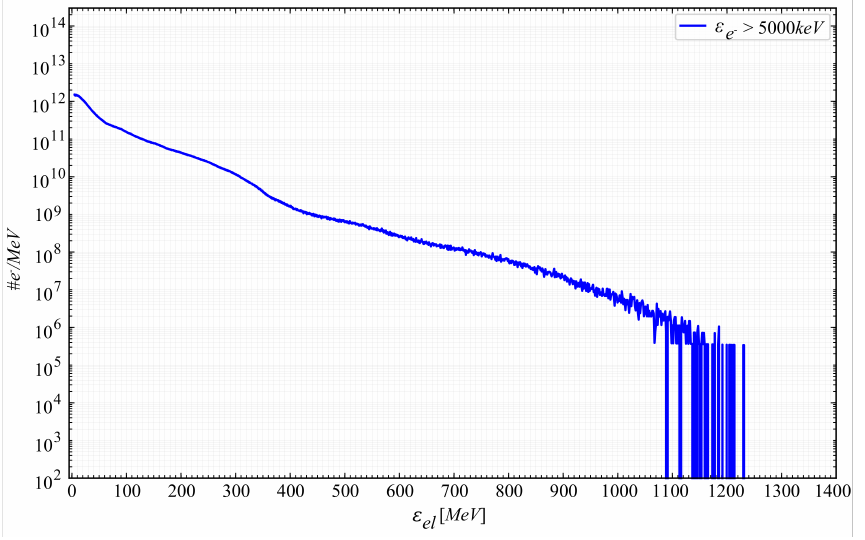
Figure 5. Electron spectra from a 2D PIC simulation. Target parameters: n e 0 = 3 n c , L x = 40 µ m and L y = 30 µ m. Laser parameters: λ = 1 µ m, a 0 = 85, τ = 20 fs FWHM and w 0 = 12.5 µ m.